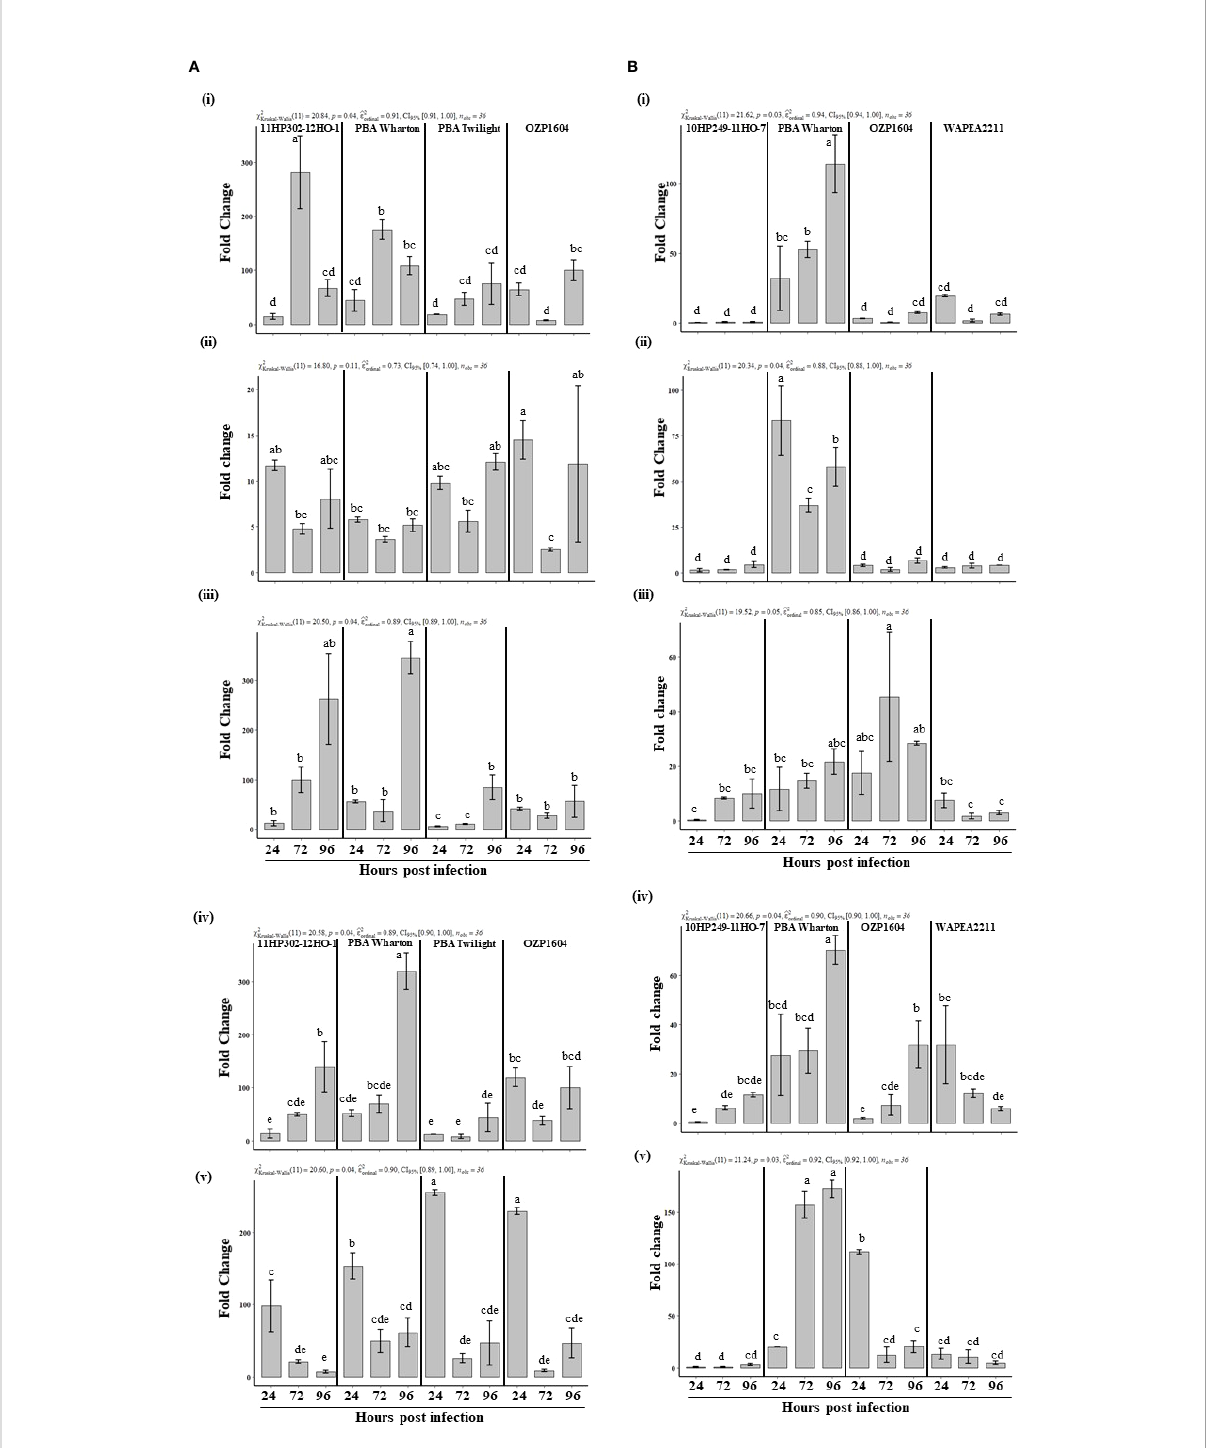
FIGURE 5 (A) Relative expression of defense related genes, PsOXII (i) , PsAPX1 (ii) , Pshmm6 (iii) , PsCHS3 (iv) , PsOPR1 (v) at 24, 72 and 96 hours post inoculation with Peyronellaea pinodes. The mRNA levels of defense related genes were normalized against reference gene PsHistone3 . The data are presented as mean ± SEM. Different letters on each bar signi fi es statistical signi fi cance among genotypes at P < 0.05 level for P. pinodes. (B) Relative expression of defense related genes, PsOXII (i) , PsAPX1 (ii) , Pshmm6 (iii) , PsCHS3 (iv) , PsOPR1 (v) at 24, 72 and 96 hours post inoculation with Didymella pinodella. The mRNA levels of defense related genes were normalized against reference gene PsHistone3 . The data are presented as mean ± SEM. Different letters on each bar signi fi es statistical signi fi cance among genotypes at P < 0.05 level for D.